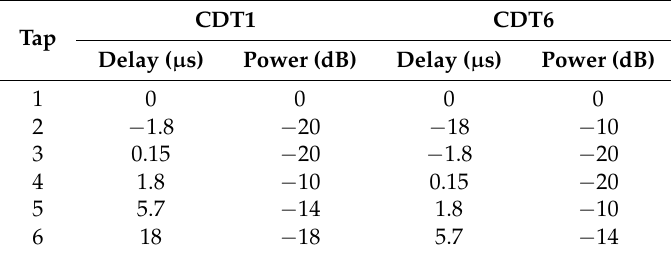
Table 1. Profiles for China DTV Test 1st (CDT1) and CDT6 multipath fading channels [17]. CDT1 Tap